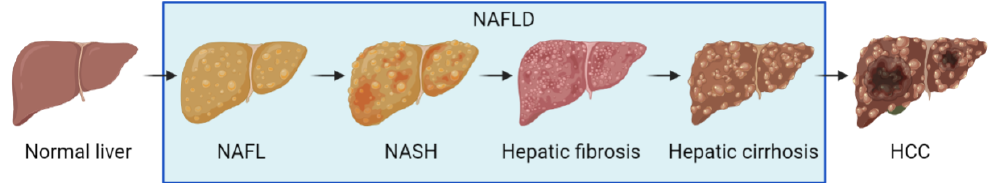
Figure 1. Schematic presentation of NAFLD progression